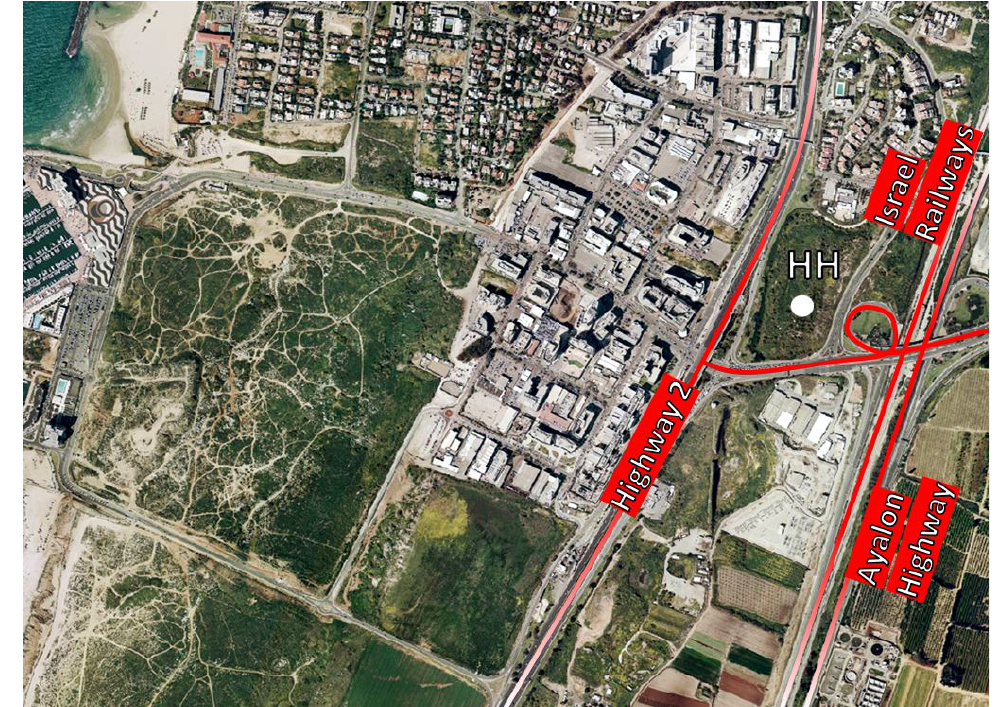
Figure 1. Aerial photograph of HH. Source: Adapted from K. Braz private